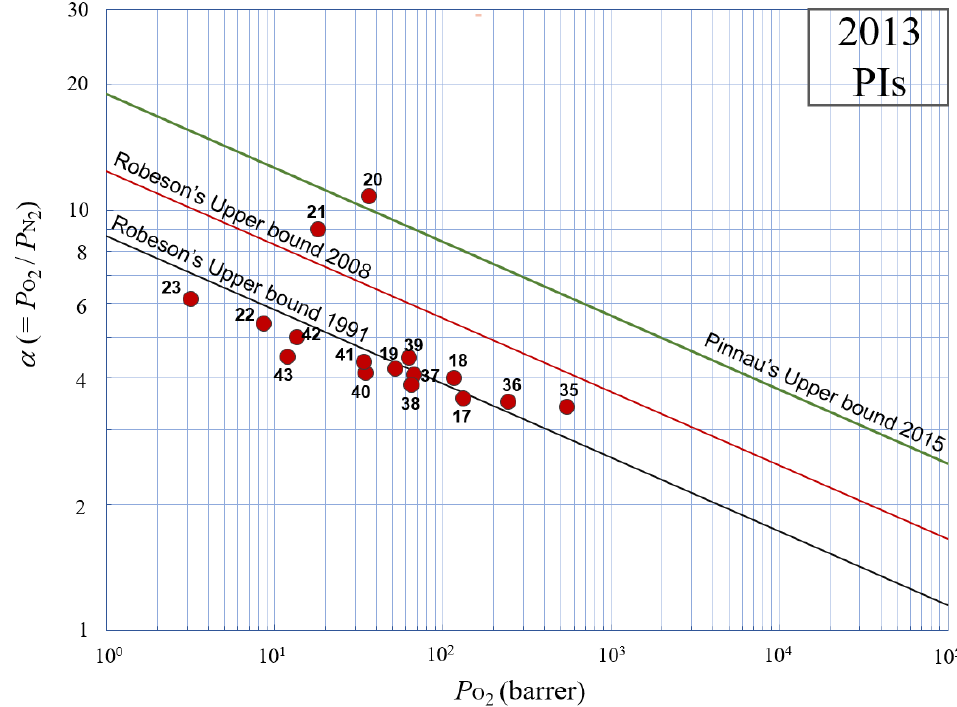
Figure 5. Plots of oxygen permselectivity through polyimides (PIs), showing the highest α at each P O 2 reported in the literature until 2013. For the data and categorization of the plots, see Table 3, and for the chemical structures of the polymers in the plots, see Charts 1 and 3.